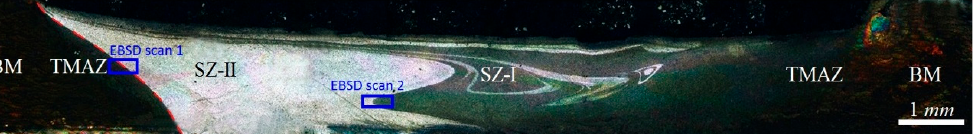
Figure 10. Cross-sectional macrostructure of 3-pass friction stir processed sample. The blue rectangles indicate the areas of EBSD scans. The details of the FSP reference frame are the same as Figure 2. Interface between TMAZ and SZ is depicted by a red-dashed line.